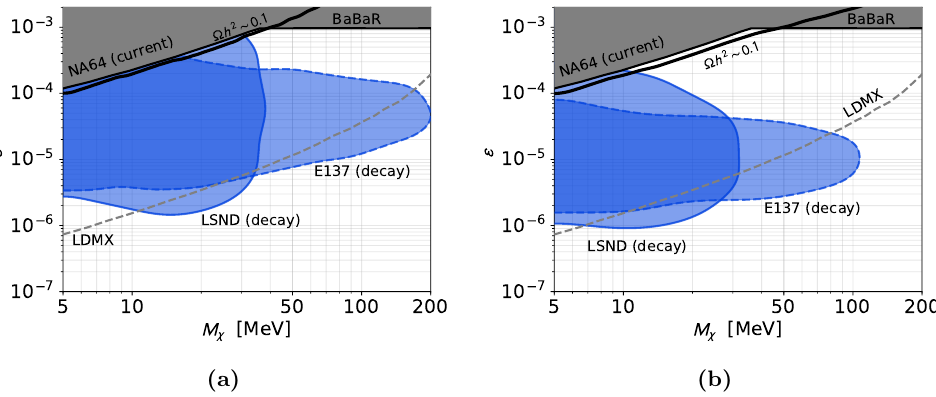
Figure 6. Bounds on the Majorana DM regime from the E137 [30], LSND [77] arising from DM scattering and (cid:31) 2 decay (blue shaded regions) and missing energy searches (grey regions and grey dashed line for the LDMX projection from [5]). The thick black lines correspond to points featuring the correct relic density of DM. We (cid:12)xed (cid:11) D = 0 : 1, determined y DM as described in the text and varied M (cid:31) and " using the mass ratios M S : M (cid:31) : M V = 3 : 1 : 4 and (a) (cid:1) (cid:31) = 0 : 8 M (cid:31)